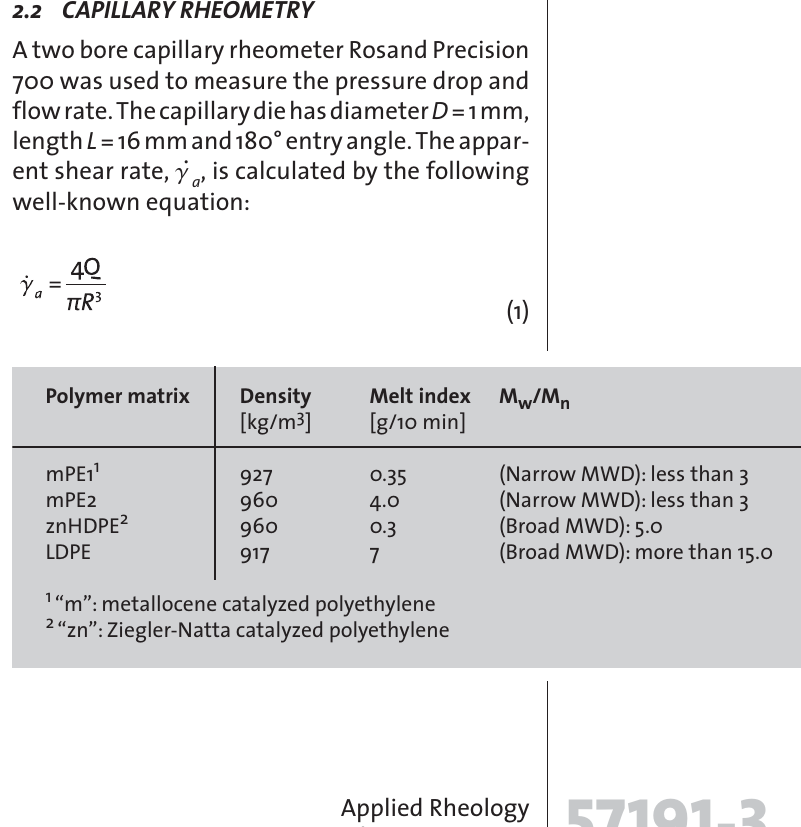
Table 1: Properties of the polymer matrices